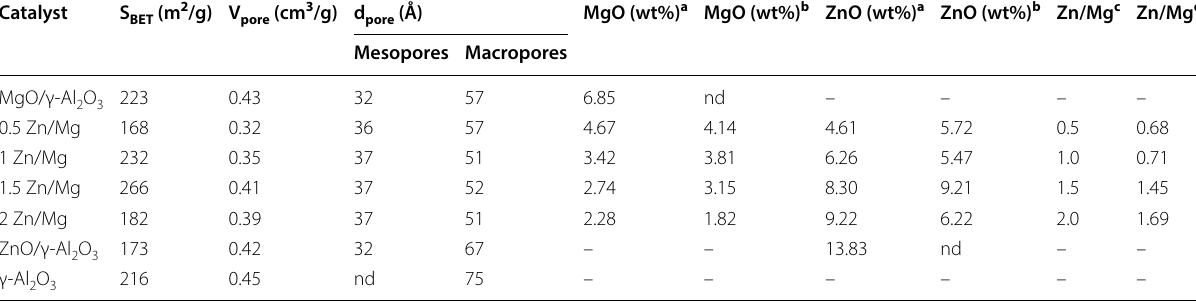
a Nominal value b Measured by AAS c Theoretical atomic ratio d Experimental atomic ratio (through AAS measurements)